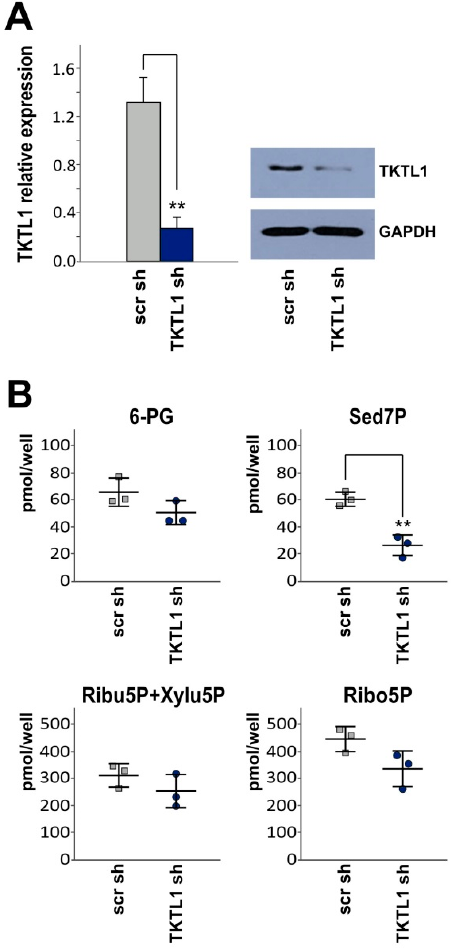
Figure 2. shRNA-mediated suppression of TKTL1 expression reduces intracellular content of sedoheptulose 7-phosphate. ( A ) shRNA-mediated TKTL1 suppression was verified by RT-qPCR (delta CT value, control, 10.08 and delta CT value, LNT-229-shTKTL1, 12.38) and western blot analysis; ( B ) LNT-229-shTKTL1 and control (scr) cells were analyzed for intracellular PPP metabolites 6-phosphogluconate (6-PG), sedoheptulose 7-phosphate (Sed7P), ribulose 5-phosphate (Ribu5P), xylulose 5-phosphate (Xylu5P) and ribose 5-phosphate (Ribo5P), ** p < 0.01.